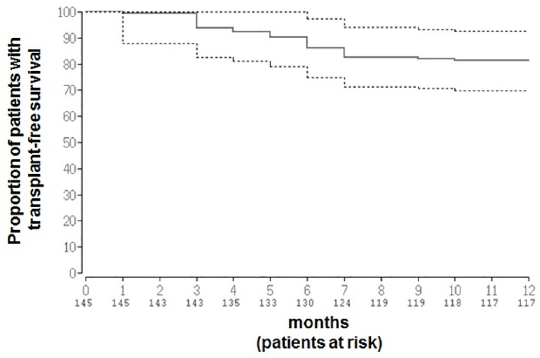
Fig 1. Kaplan Meier curve of transplant-free survival. Proportions (solid line) and confidence intervals (dotted lines) of patients surviving without liver transplantation during 12 months of follow-up are shown. Bilirubin (beta = 0.17, 95% CI = -0.01–0.36, P = 0.06) and protein C (beta = -0.03, 95% CI = -0.05 - -0.005, P = 0.01) were independently associated with transplant-free survival in Cox regression